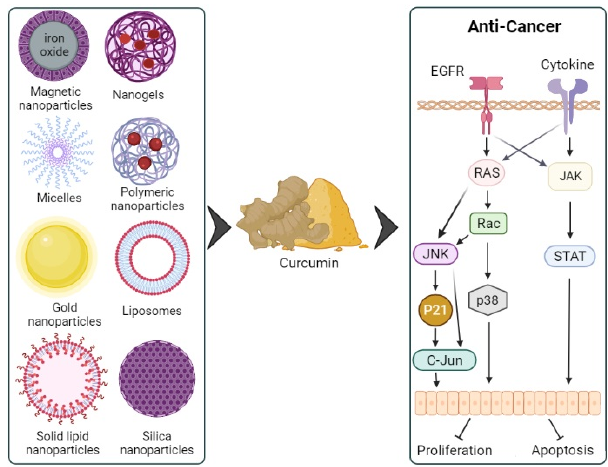
Figure 2. CUR-containing NP formulations with anticancer potential.